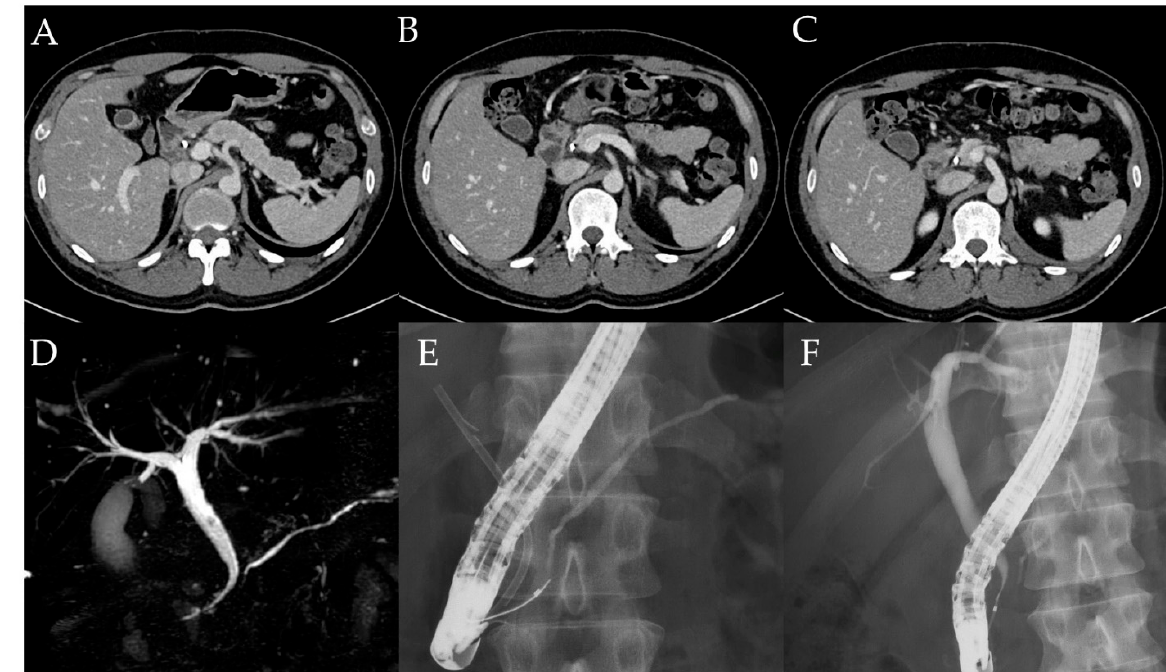
Figure 5. Imaging findings after steroid introduction. ( A – C ) CT. ( D ) Magnetic resonance cholangiopancreatography. ( E , F ) ERCP. Pancreatic enlargement, MPD stenosis, and bile duct stricture all improved after steroid introduction.